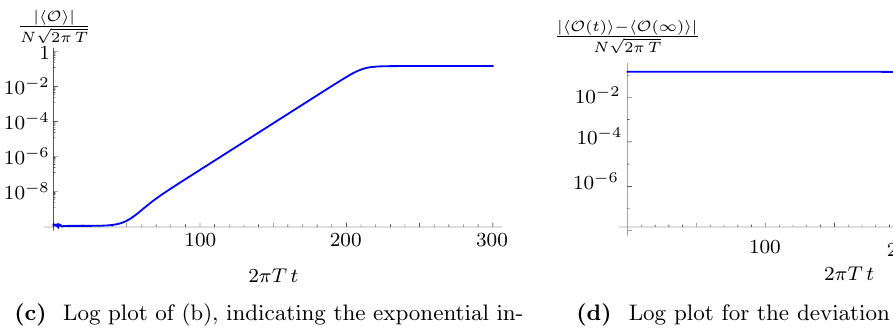
(d) Log plot for the deviation at late times, indi- stability. cating the QNM ringdown to the equilibrium value for the new coupling (cid:20) f = (cid:20) nc 1 ( 1 ). Figure 1. Typical numerical evolution of the scalar operator (b) for a quench from the normal to the condensed phase (a). Note the di(cid:11)erent time scales involved due to the instability mode (c) and the QNM ringdown to the (cid:12)nal equilibrium (d).